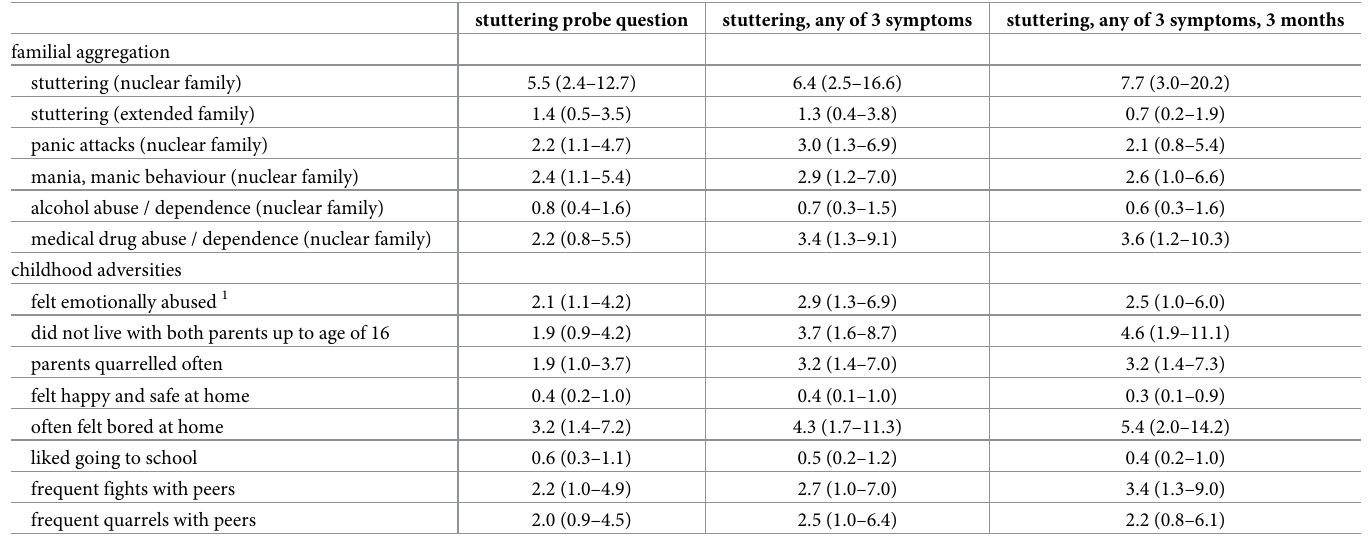
Table 3. ZInEP: Familial aggregation and psychosocial risk / associated factors related to stuttering. Odds ratios and confidence intervals (95%), adjusted for